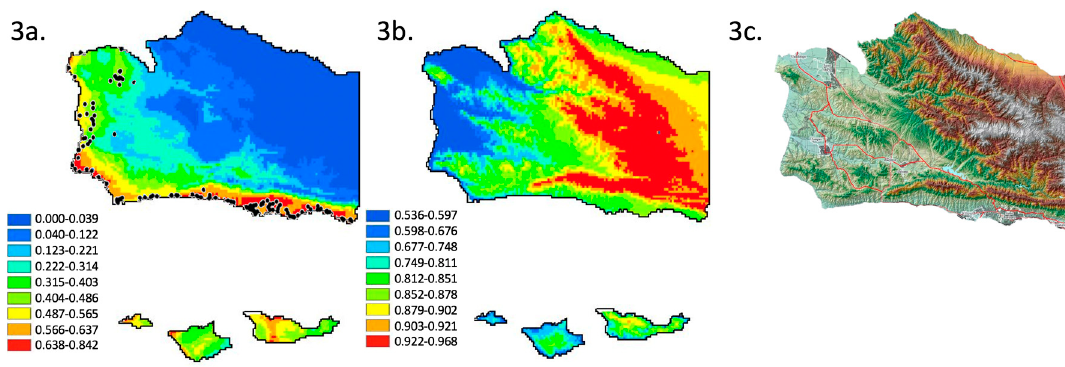
Figure 3. Results of a MaxEnt climate niche model analysis for the current and future distribution of monarch butterfly overwintering habitat in Santa Barbara County, California, generated using an optimized regularization parameter, and two elimination methods for reduction of over parameterization which converge on the selected layers: ( a ) analysis for the current distribution using, WorldClim 2.0 layers, and showing the location of known overwintering sites (as in Figure 1) and, ( b ) corresponding 2050 extrapolated distribution, calibrated using WorldClim 1.4 layers under the RCP4.5 projection, and ( c ) relief map of the county. Relative probabilities for each model are indicated by separate color legends, with ( b ) showing overall higher relative probabilities. The difference between present and extrapolated maps generated by this model suggests the current coastal zone/coastal valleys distribution will be replaced by a higher elevation distribution, where the probability of suitable climatic conditions will be proportional to elevation.